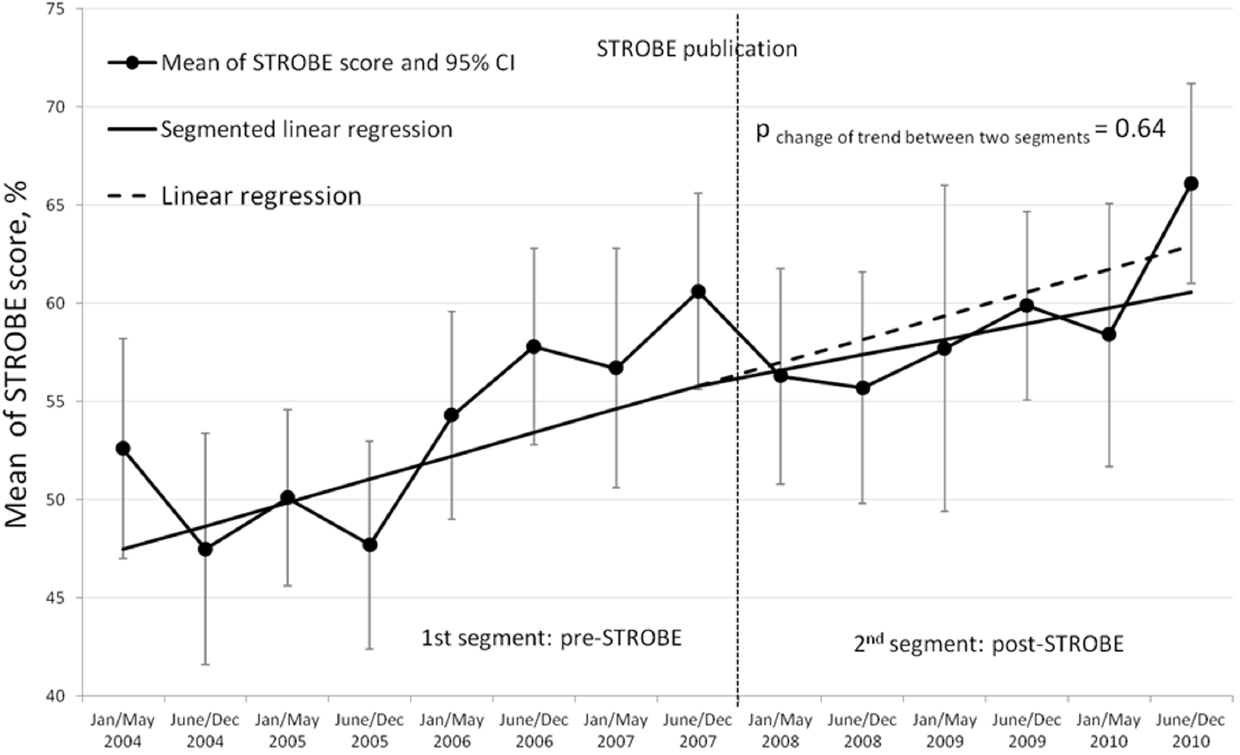
Figure 2. Time series of six-monthly mean STROBE scores and values predicted from the segmented and simple linear regression models.